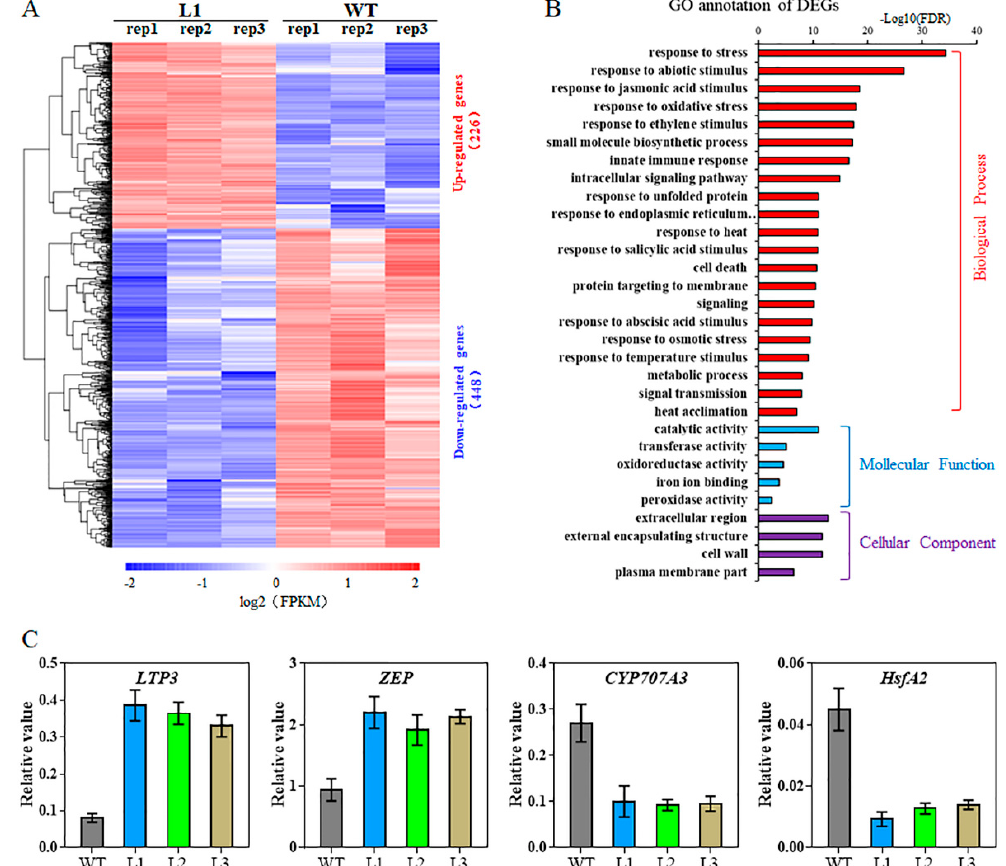
Figure 7. Transcriptomic analyses of TaHsfA6f transgenic Arabidopsis . ( A ) Heat map of DEGs in leaves of transgenic vs. WT plants. The heat map represents the gene expression levels of 674 significant DEGs (log2Foldchange > 1 and FDR < 0.001) between transgenic (L1: rep1, rep2 and rep3) and WT (WT: rep1, rep2 and rep3) plants. The indicated scale is the log2 value of the normalized level of gene expression. ( B ) Gene ontology classification for DEGs in TaHsfA6f transgenic and WT plants. ( C ) qPCR validation of RNA-seq results for DEGs. Error bars indicate standard deviations. Table 1. The list of DEGs in TaHsfA6f transgenic Arabidopsis that are highlighted in this paper.